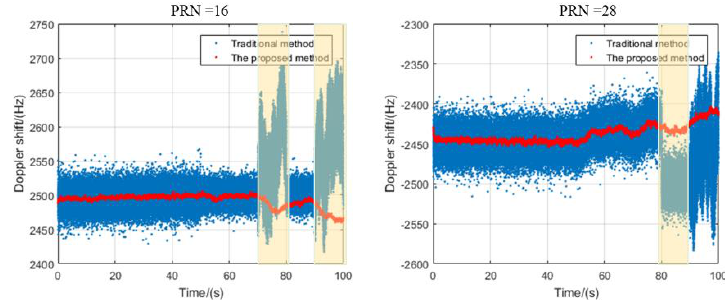
Figure 9. The Doppler shift values of satellite signals (PRN =16,28).